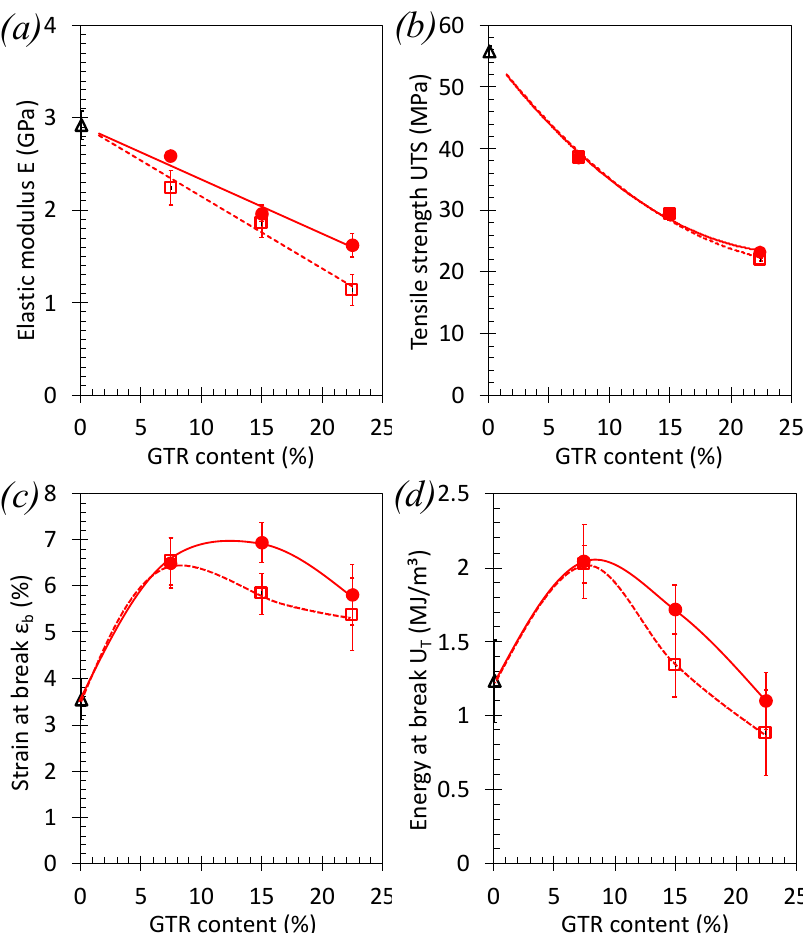
Figure 8. Effect of the GTR content on the tensile properties of PLA/GTR blends. ( a ) elastic modulus, E T , ( b ) tensile strength UTS, ( c ) strain at break, ε b , and ( d ) energy at break, U T , from tensile test performed at 10 mm ∙ min − 1 and at room temperature on the neat PLA in absence of DCP (black triangle symbols), PLA/GTR a in absence of DCP (red unfilled square symbols) and in presence of 1.5 wt% of DCP (red filled circle symbols). All blends were processed at 170 °C in presence of Irganox (0.2 wt% of total amount of material). The continuous and dotted lines are guide for the eyes for the series of data associated with blend using DCP and without DCP, respectively.